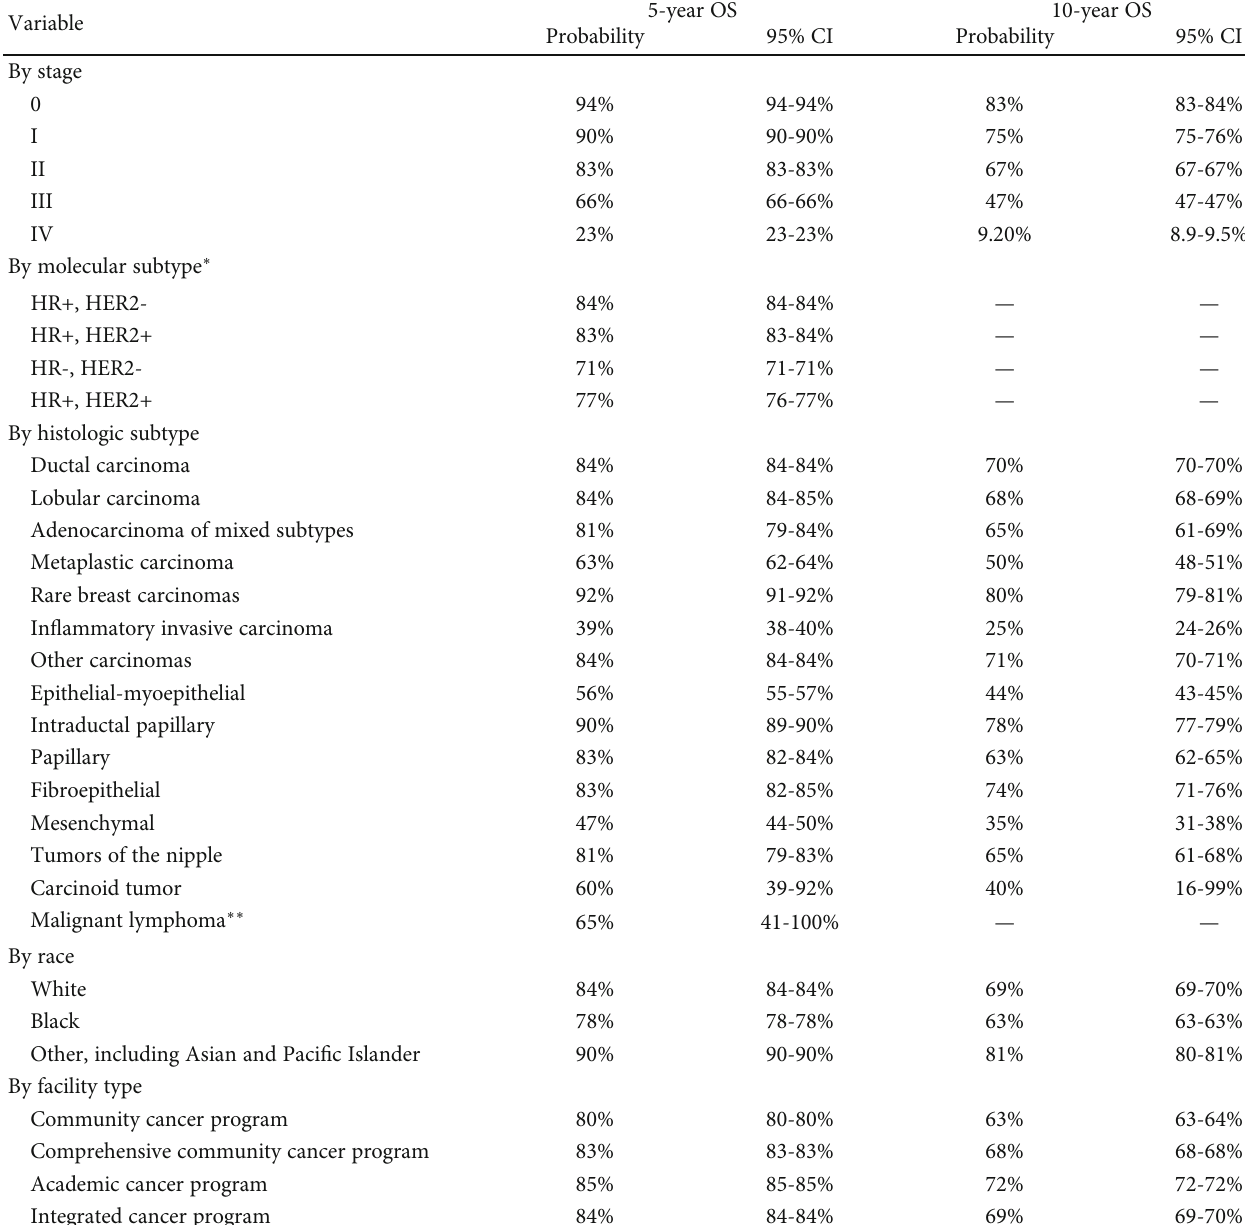
Table 3: 5-year and 10-year overall survival (OS) of patients diagnosed between 2004 and